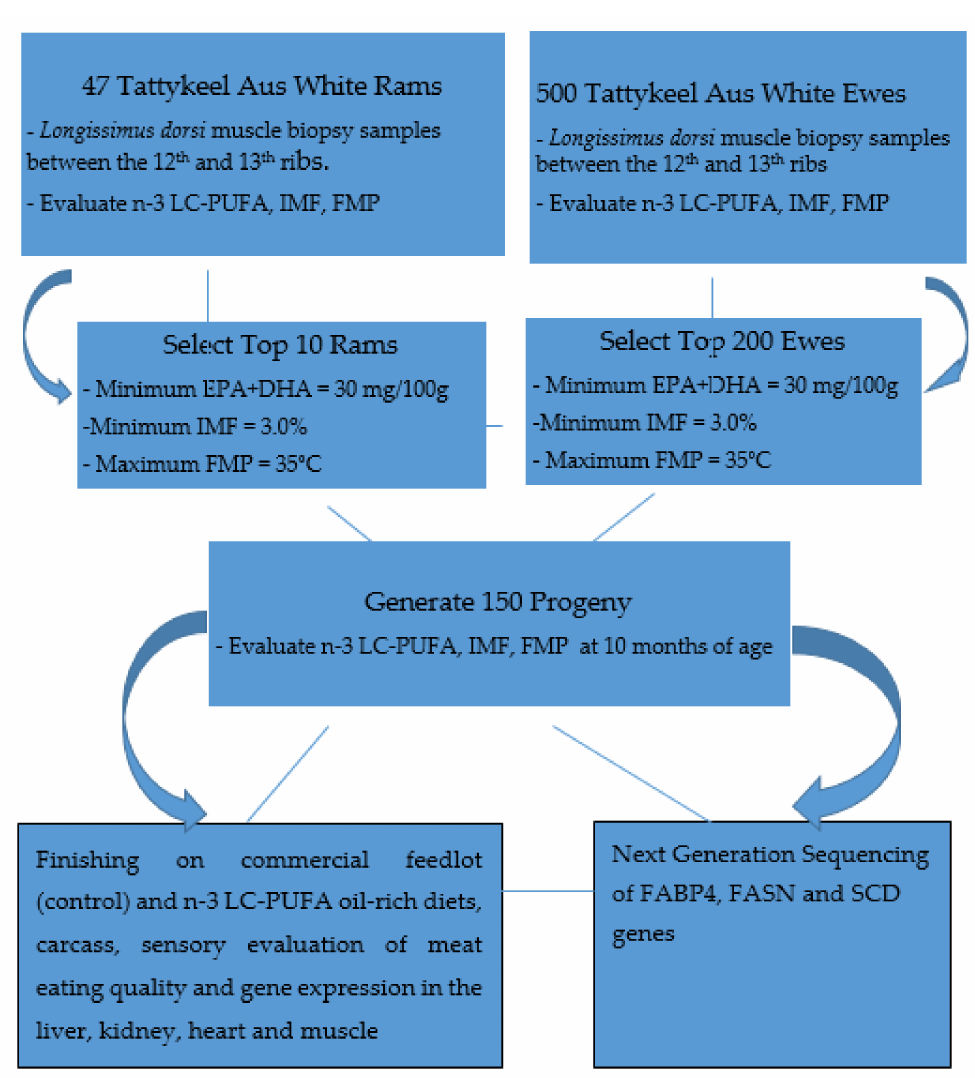
Figure 1. Experimental design for the selection, breeding, and evaluation of n-3 LC-PUFA, IMF, and FMP in Tattykeel Australian White